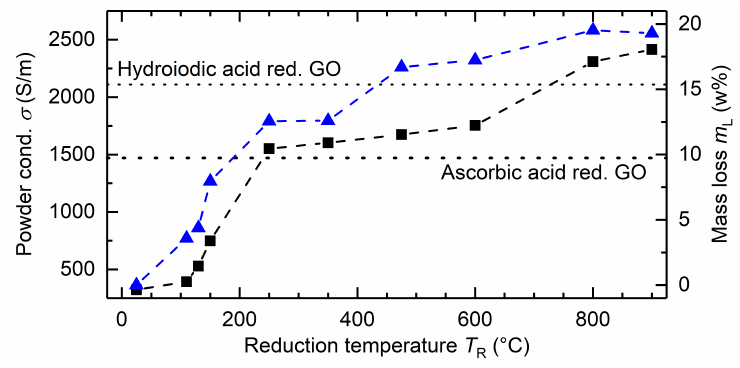
Figure 4. The graph shows on the left axis (in black) the powder conductivity σ and on the right axis (in blue) the reduction mass loss m L , both as a function of the reduction temperature T R